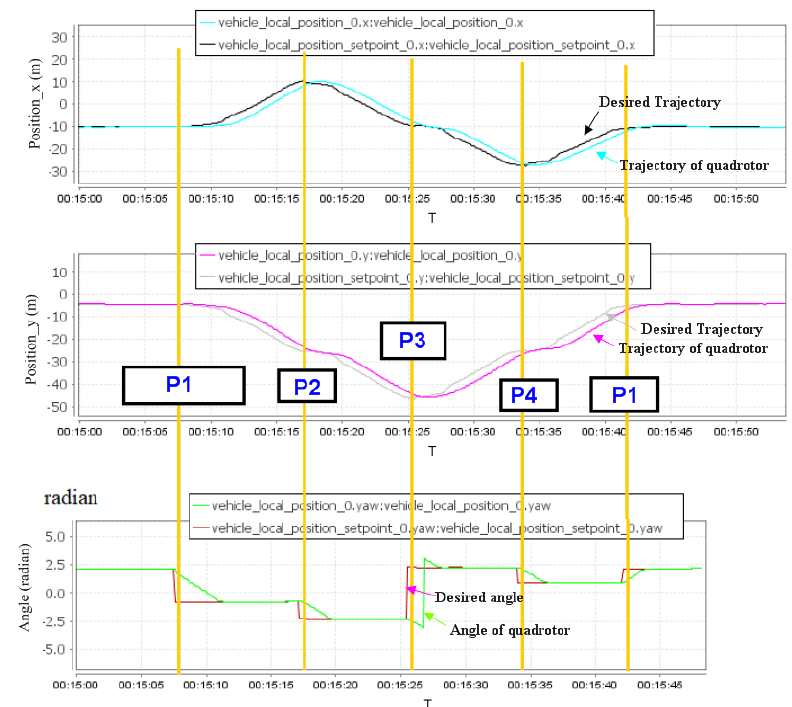
Figure 11. Position response of quadrotor in experiment.